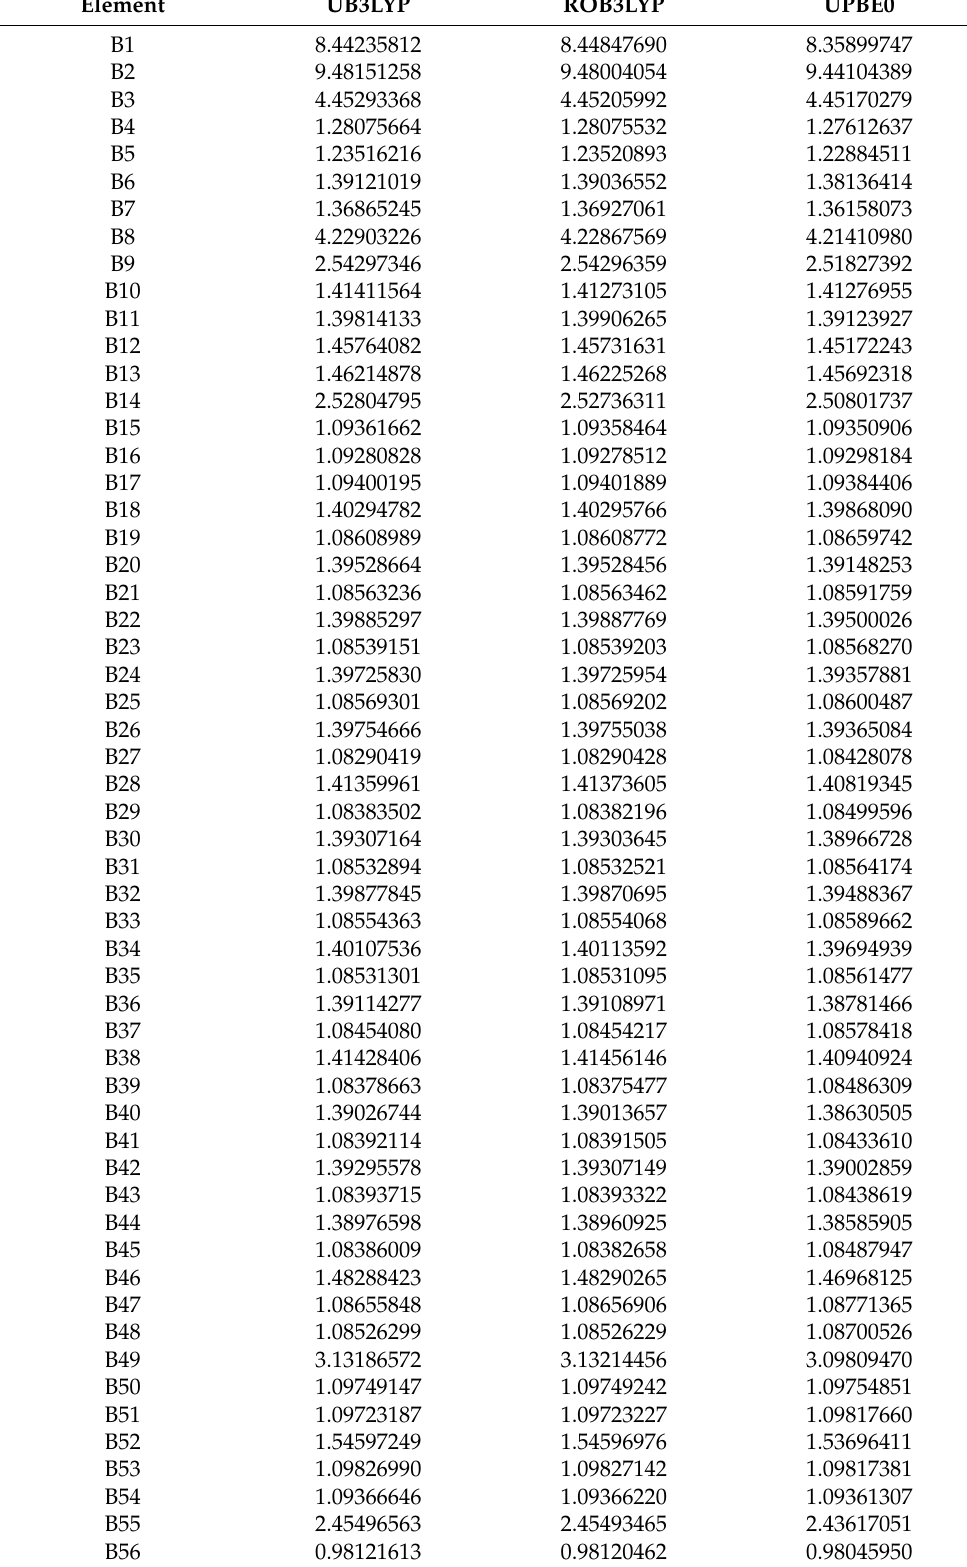
Table A4. Elements of the Z − matrix of ATV1H in methanol optimized as indicated below using 6-31+G/d,p) basis